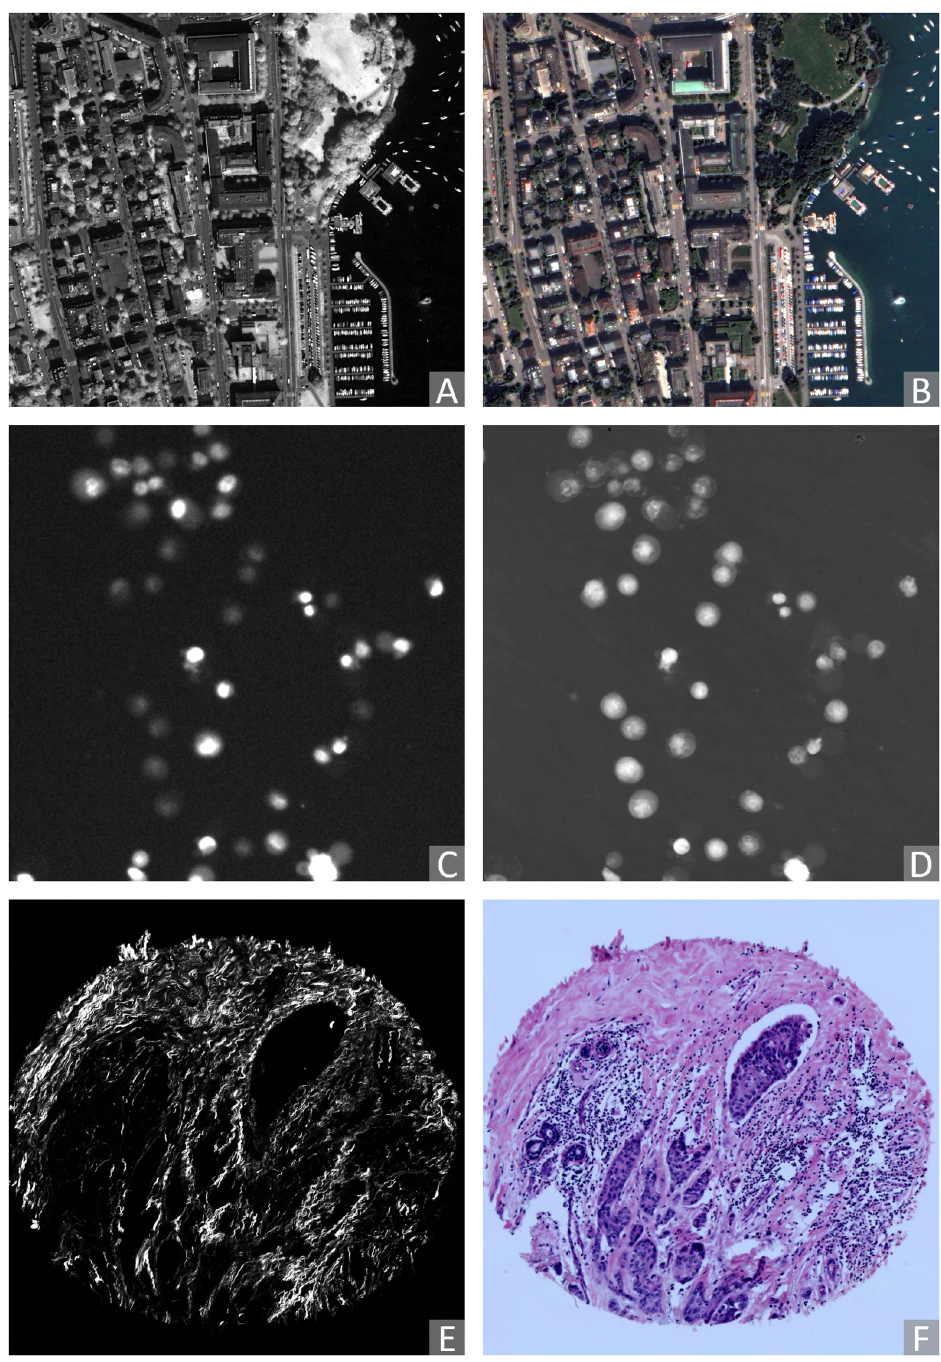
Fig 2. Examples of pairs of original (2D) images acquired by different modalities considered in this study (contrast enhanced for visualisation). Zurich (remote sensing) dataset: (A) modality A: NIR, (B) modality B: RGB. Cytological data: (C) modality A: Fluorescence microscopy, (D) modality B: QPI. Histological data: (E) modality A: SHG, (F) modality B: BF.